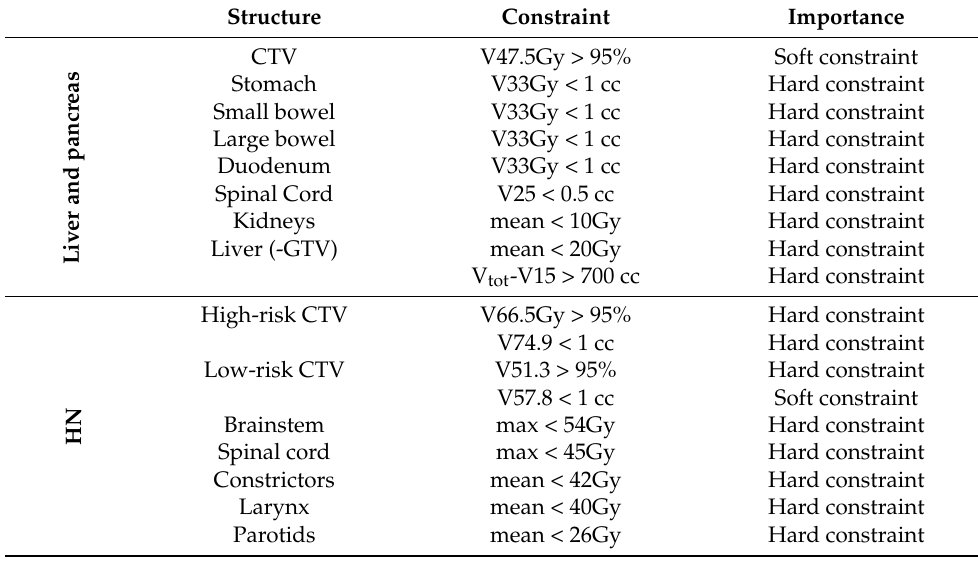
Table 2. Planning constraints for pancreas, liver, and HN cancer patients.